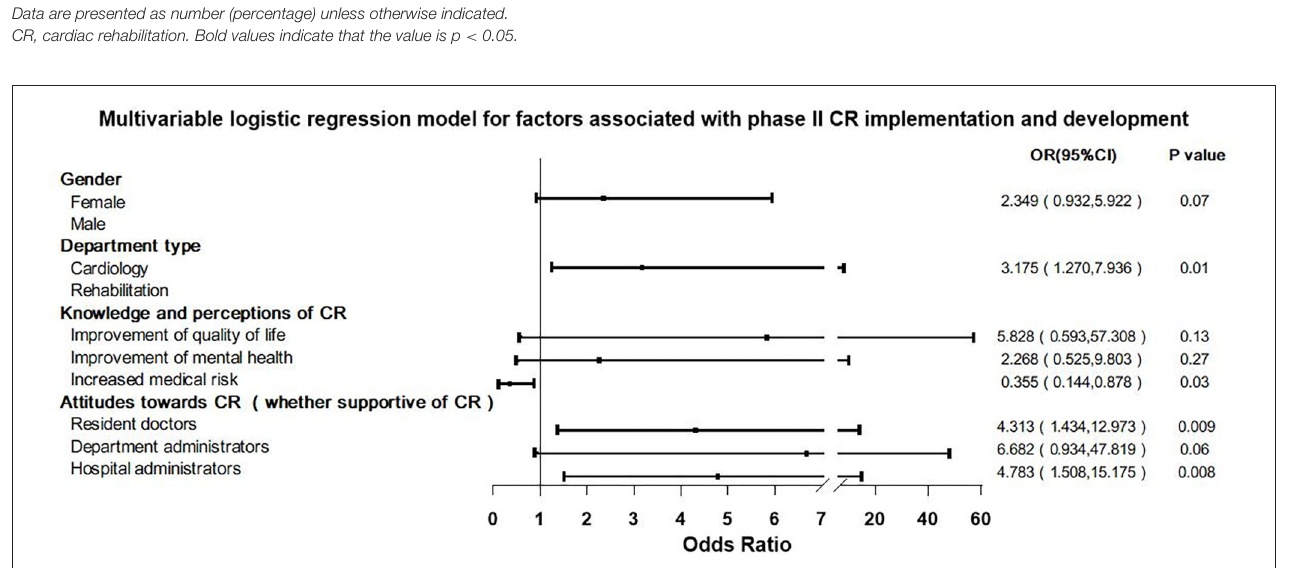
attitudes toward CR among six types of clinical staff between the two groups ( Table 2